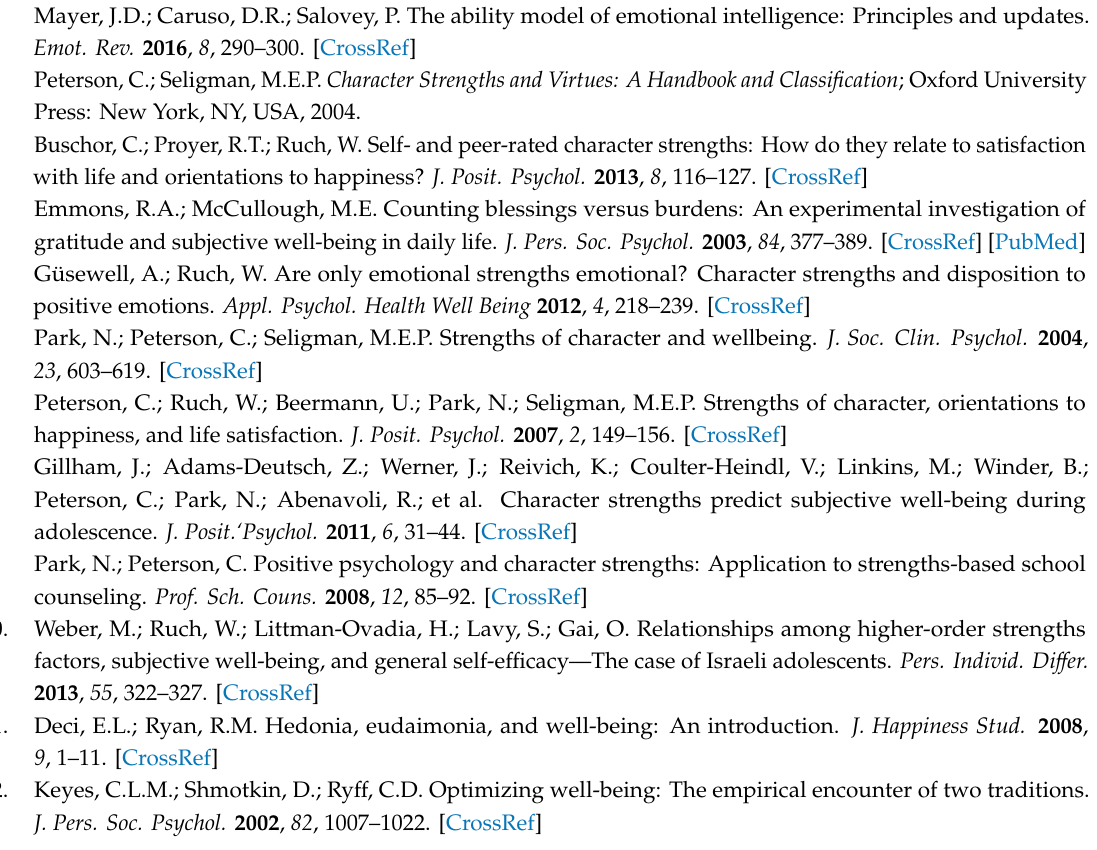
Figure A2. Parallel multiple mediator model of social intelligence, subjective well-being, psychological well-being, and psychological distress for men. Standardized coefficients and standard errors ( SE ) are shown in the figure. * p < 0.001.